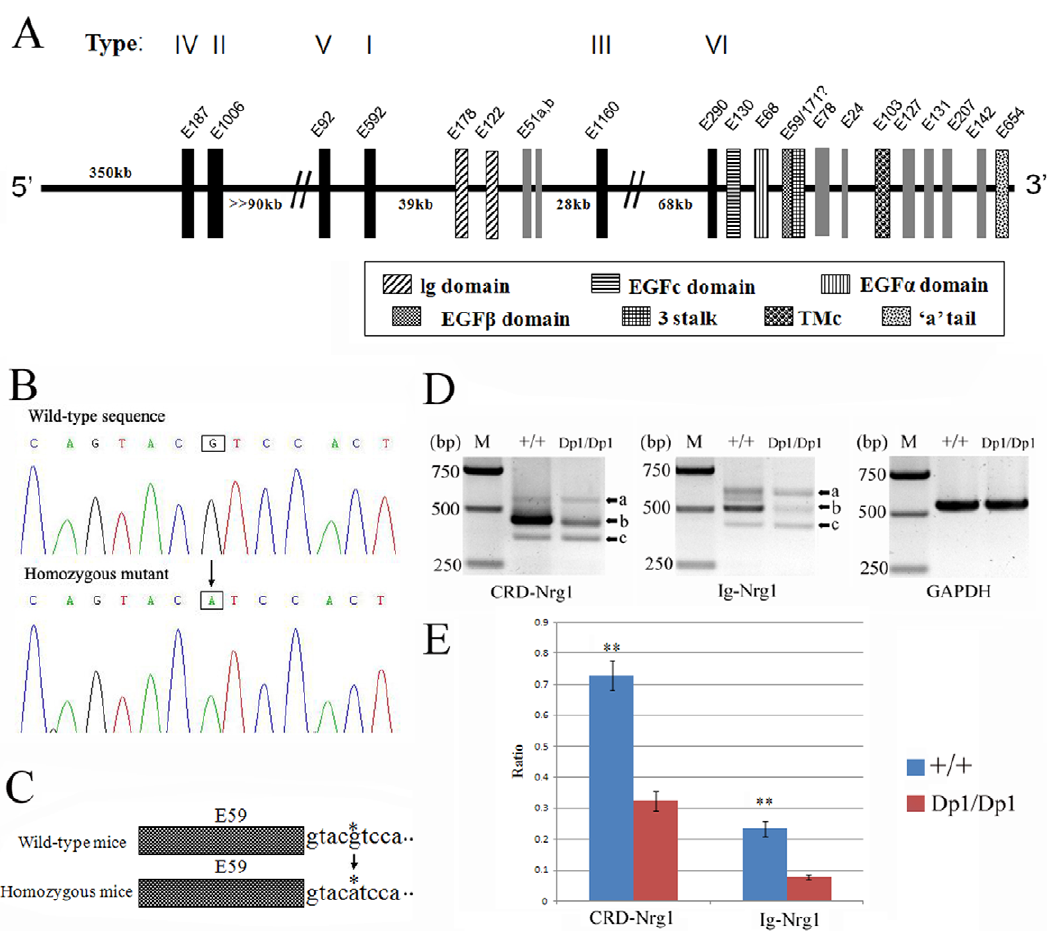
Figure 3. Nrg1 gene structure and mutation identification. (A) Mouse Nrg1 gene structure. Exons are represented as vertical bars and are numbered as per Steinthorsdottir et al. [2004], Paul et al. [2006] and Chen et al. [2008]. In the absence of an agreed or definitive exon numbering system for NRG1, exons are labeled as described by Steinthorsdottir et al. [2004] with the number denoting their length in nucleotides. The 5 9 exons, which define the ‘‘types’’ of NRG1, are in black with the corresponding Roman numeral above (including three additional 5 9 exons found in humans that encode type IV, V, and VI). In mice, exon E171 may encode isoforms with a ‘‘3’’ stalk (see Figure 4 and 5). (B) Sequence analysis of the Nrg1 gene product obtained using PCR of genomic DNA discovered a G to A transition mutation in Dp1/Dp1 homozygous mice compared to wild-type B6 mice. (C) The mutation located in the 5 9 splice donor site that flanks exon E59 encoding the EGF b domain. (D) Electrophoresis results using primers specific for CRD-Nrg1 and Ig-Nrg1 from homozygous Dp1 and wild-type B6 mice, respectively. M, molecular weight markers. GAPDH, glyceraldehyde-3- phosphate dehydrogenase. (E) Quantitative analysis of Nrg1 mRNA levels in band b by densitometry. Ratio: ratio of volume (intensity) of respective Nrg1 and GAPDH mRNA RT-PCR product. **p , 0.01 vs. respective Dp1/Dp1 group